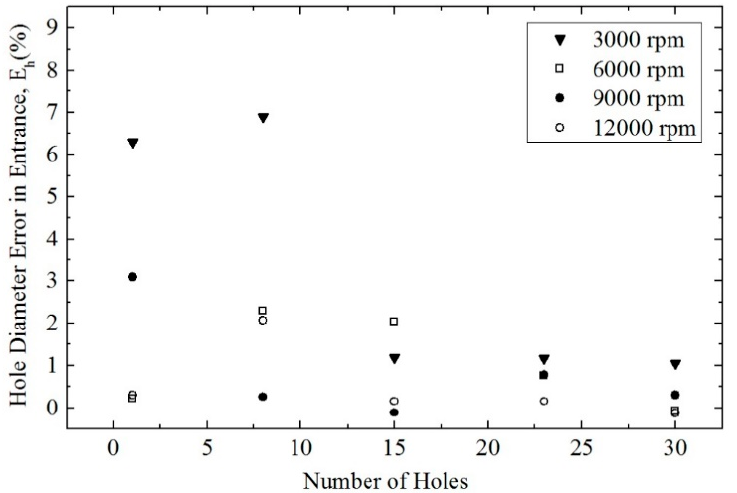
Figure 8. Variation of hole diameter error E h (%) with number of holes on entrance side at feed rate of 400 mm/min.